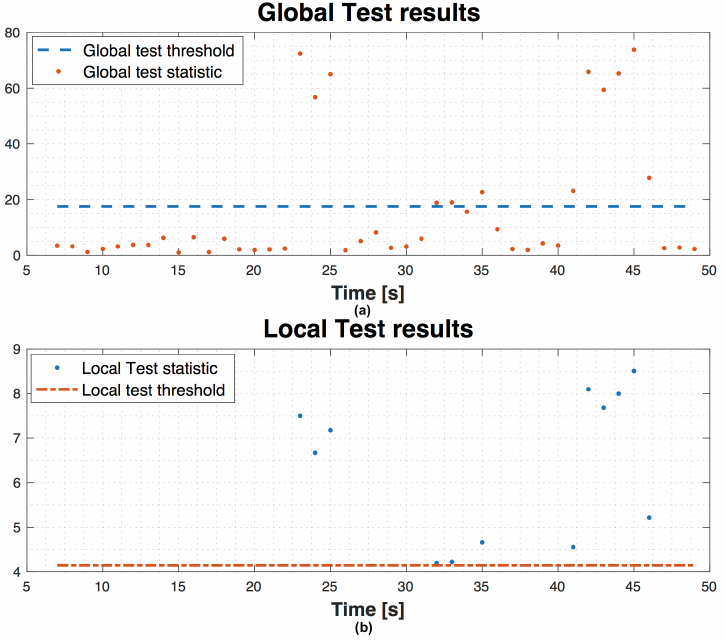
Figure 14. Example of global ( a ) and local ( b ) test assisted by SQI information on scenario 1 without unreliable